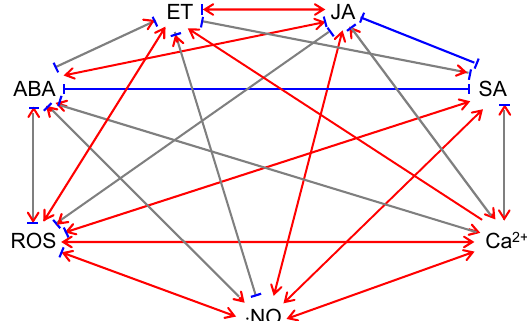
Figure 1. Interactions among defense-related signals. Red arrow heads represent positive (promoting) effects; blue bars represent negative (inhibitory) effects; grey lines with red arrow heads and blue bars represent both positive and negative effects. This is not an exhaustive presentation of all defense-related signals, but it shows the major ones discussed in this review.